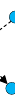
dated. In the same way, the remaining three child nodes of i 1 and i 3 need to receive the tide, as well as the result of network redistribution.